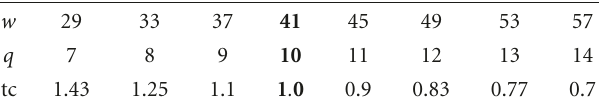
Table 1: Tempo changes (tc) simulated by changing the statistics window size w and the downsampling factor q